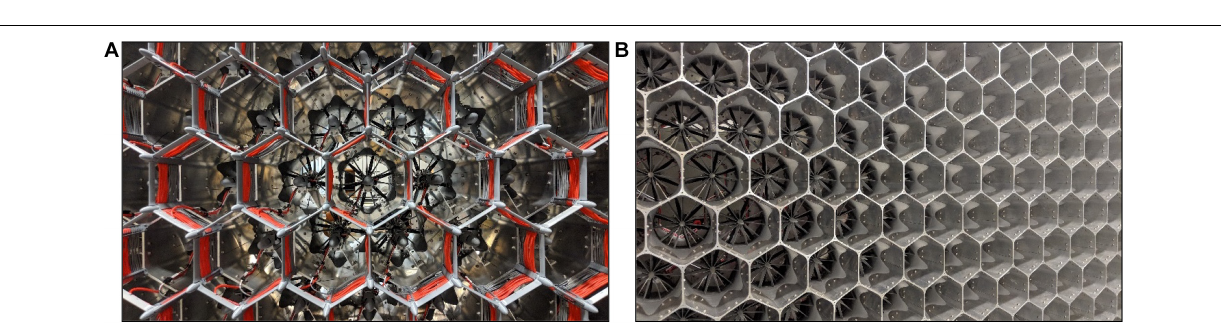
identical 319 cell honeycomb shown in Figure 1 . The FFM